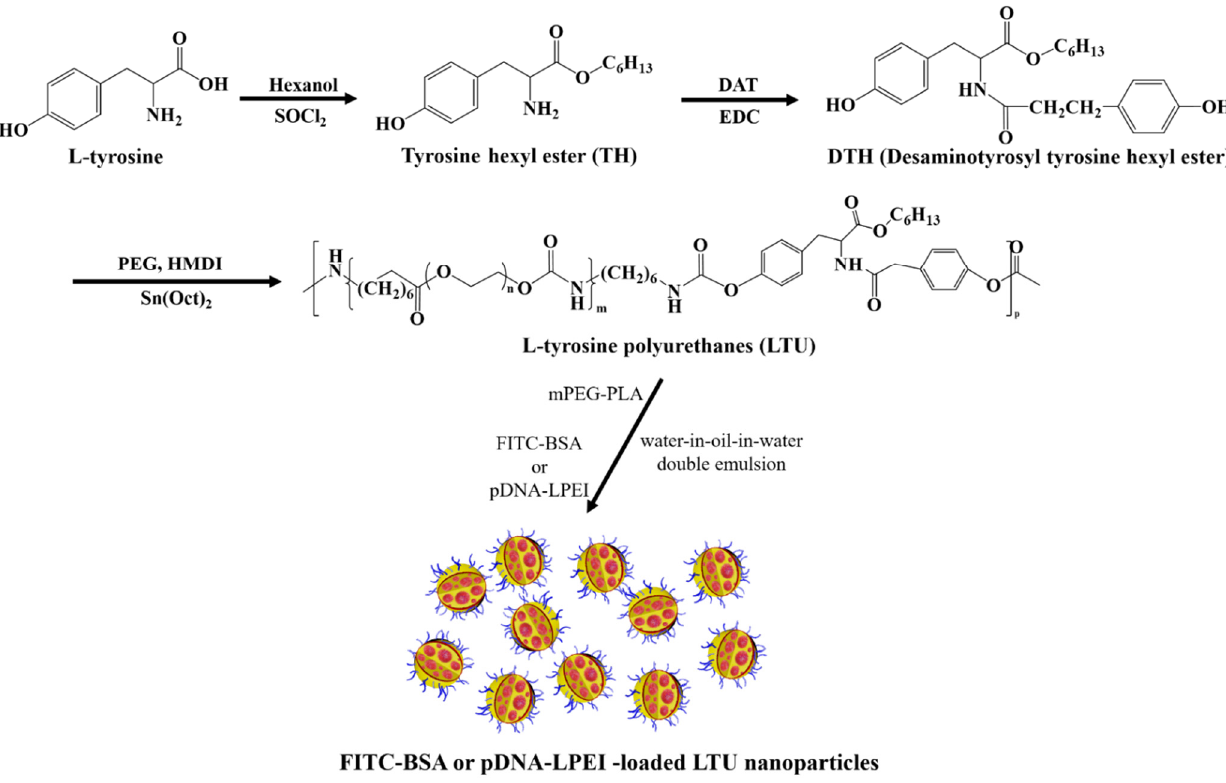
Figure 7. Synthesis of L-tyrosine polyurethane (LTU) and its fabrication of nanoparticles.